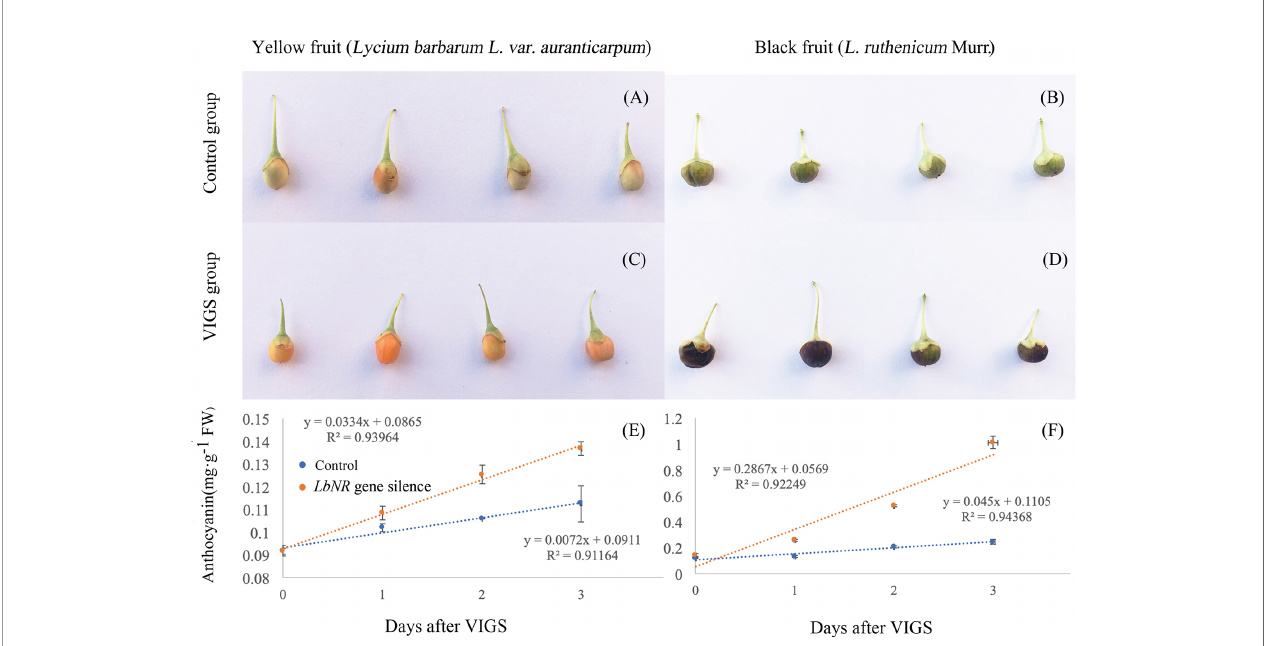
FIGURE 5 | The fruit phenotypes and coloration rates after virus-induced LbNR gene silencing. (A, B) Phenotypes of YF and BF at 2 d after injection with the pTRV empty vector, respectively. (C, D) Phenotypes of YF and BF at 2 d after LbNR gene silencing, respectively. (E, F) The coloration rates within 3 d after VIGS injection of YF and BF, respectively. For injection, the needle is inserted into the growing point of the green stage fruits (S2) for pressure injection. The error bars represent the SDs of three independent replicates. The asterisks on the bars for the same species indicate signi fi cant differences between the treatments (p <